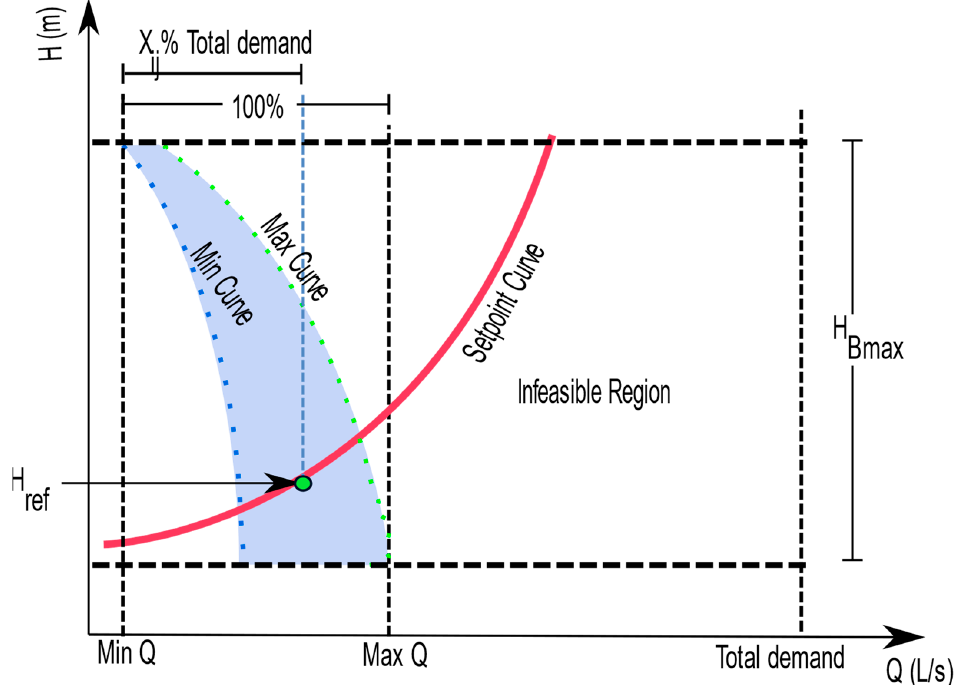
Figure 2. Decoding a solution for a 2-PS problem.